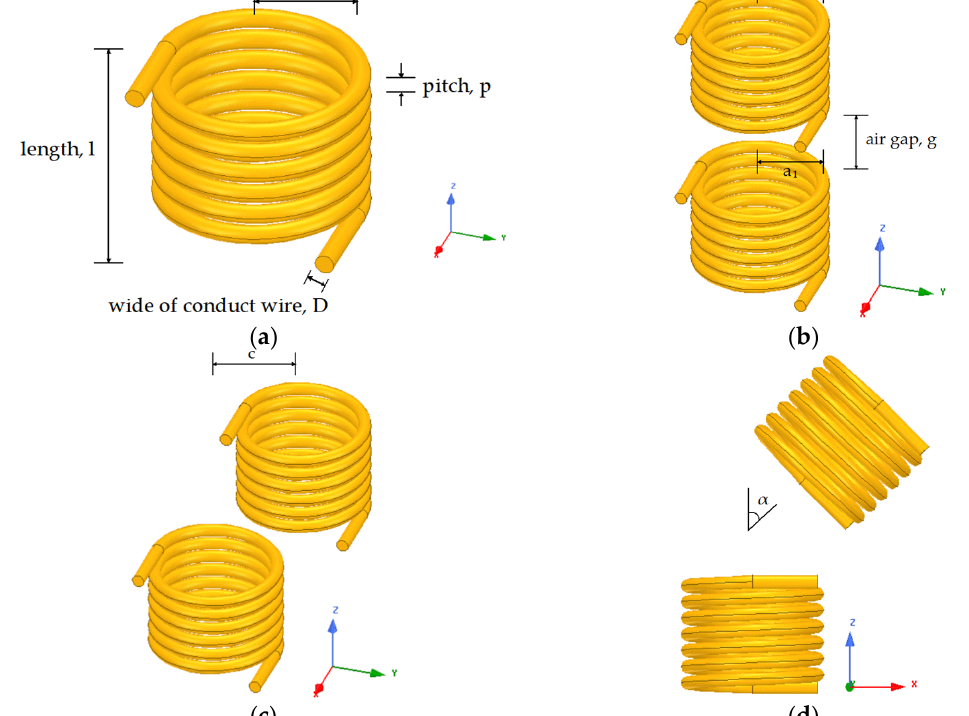
Figure 3. ( a ) Helical coupling coil and ( b ) air gap between two coupling coils; ( c ) lateral misalignment and ( d ) angled misalignment.